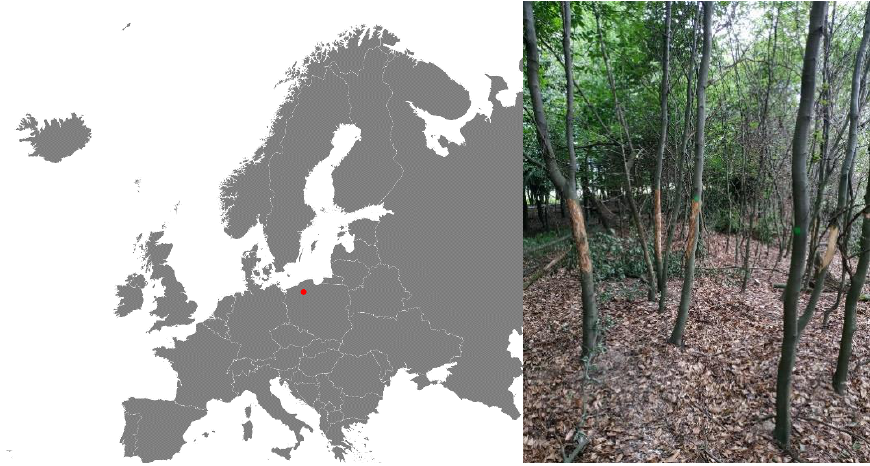
Figure 1. The location of the research area and significant damages of beech tree stands by the deer in the area of the State Forests in Poland (photo K. Lewandowski).